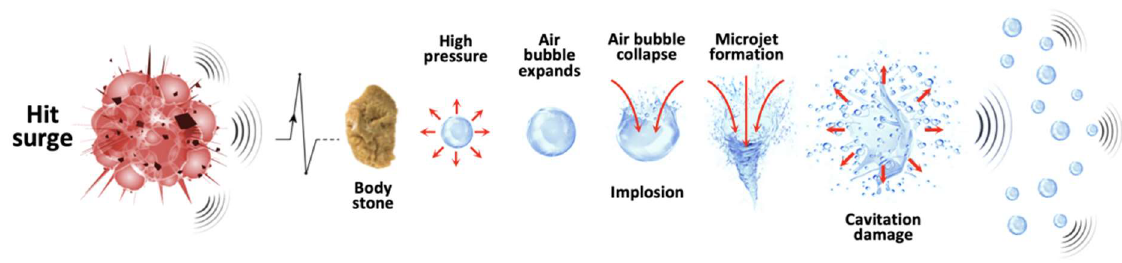
Figure 2. Chain reaction initiated by a shock wave in the tissue.